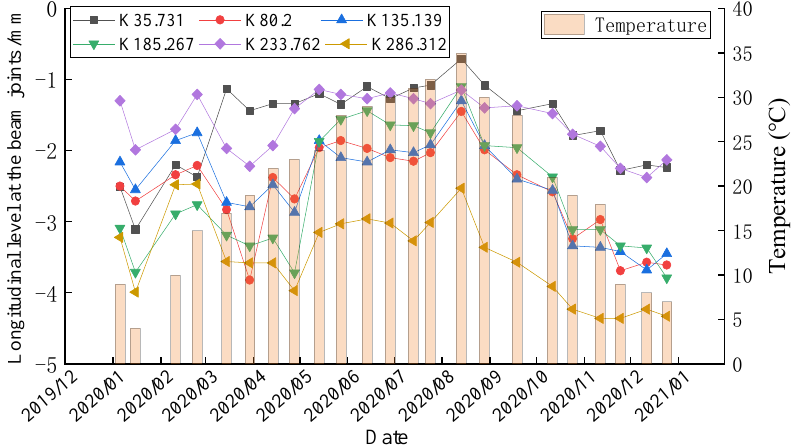
Figure 5. Variation of the longitudinal level at the beam joint and temperature with time.